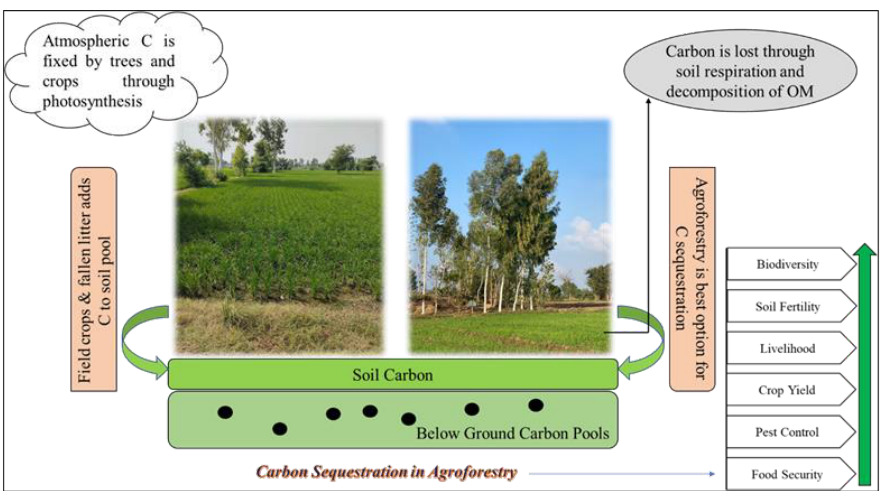
Figure 3. Schemes of carbon sequestration in agroforestry.